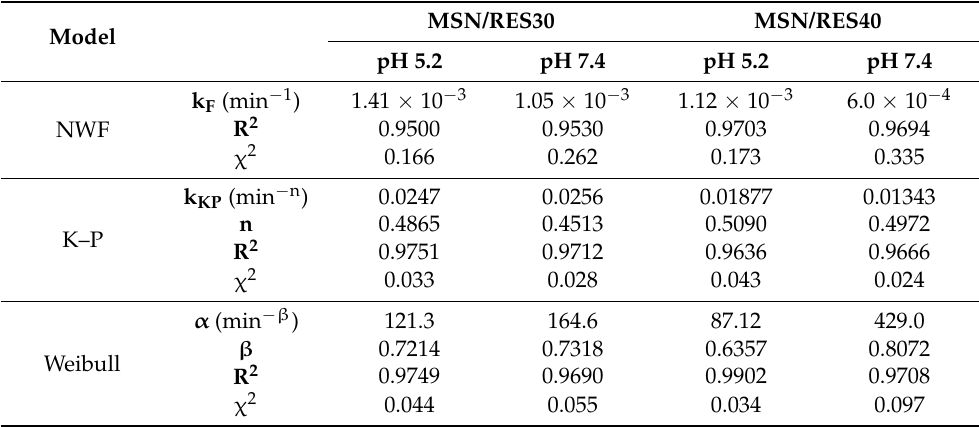
Table 2. Kinetics parameters and goodness of the fits of RES release from loaded MSNs. k F : first-order rate constant independent of drug concentration; k KP : constant incorporating characteristics of the system; NFW: Noyes–Whitney and Fick’s law equation; K–P: Korsmeyer–Peppas